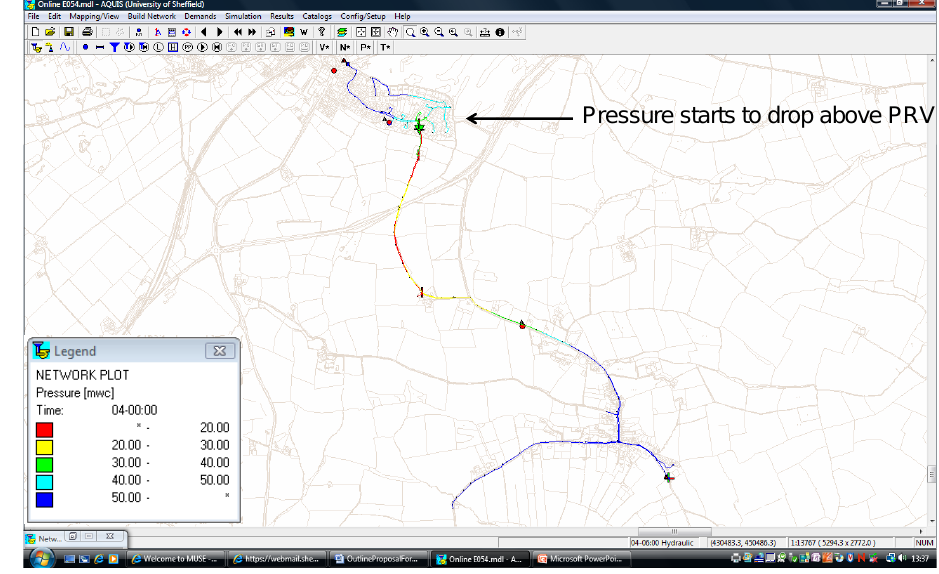
Figure 4. Pressure e ff ect of event at 06:00.